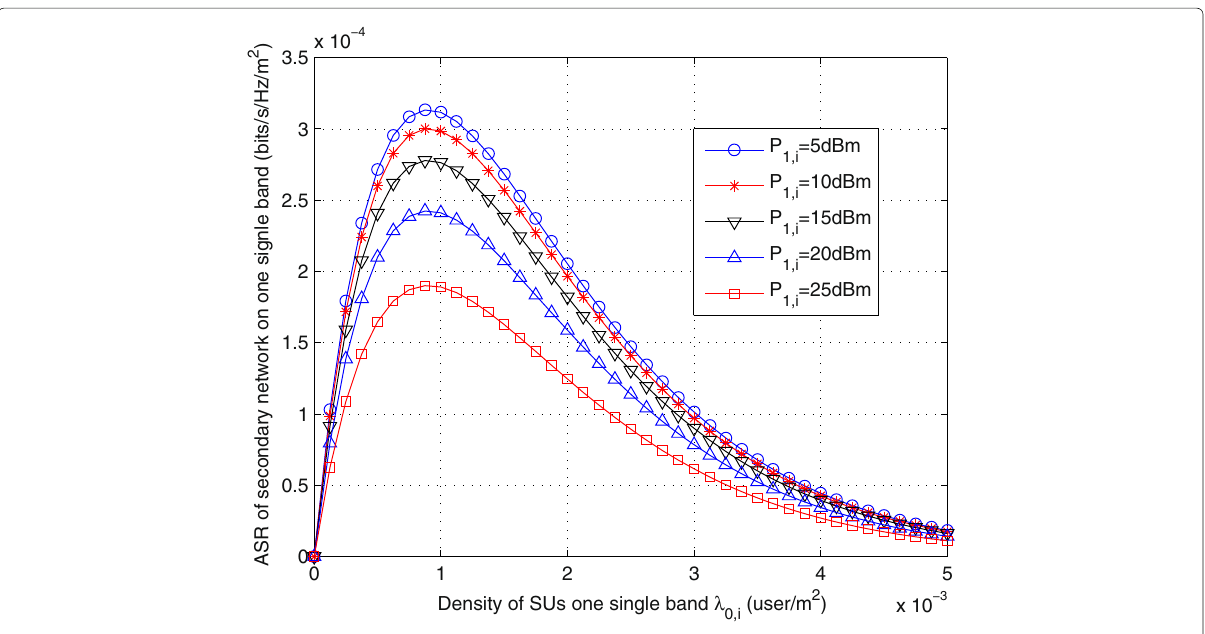
Fig. 7 ASR of secondary network vs. Density of SUs on one single